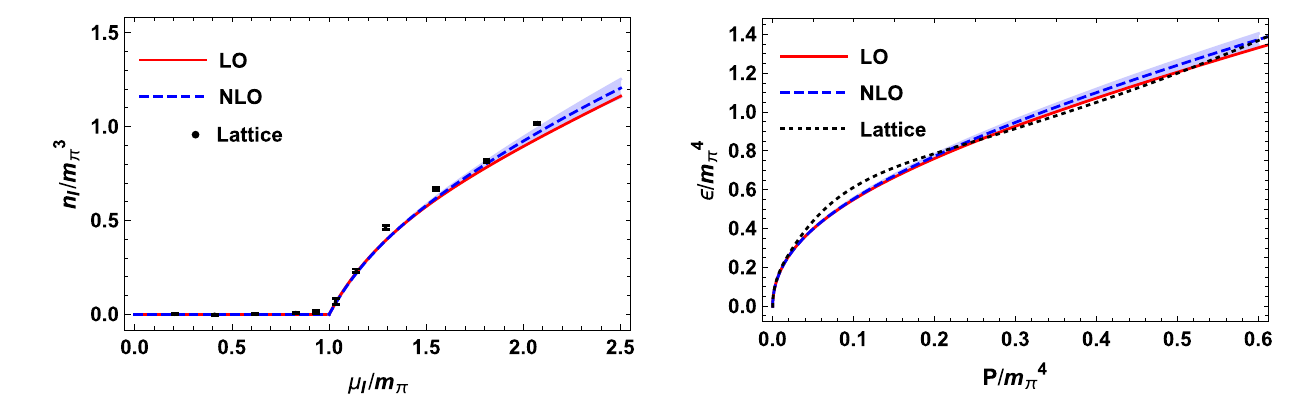
Fig. 5 The normalized equation of state at tree level is the red curve and at one loop is the blue curve using the central values m cen and f cen . The blue band is obtained by varying the parameters m and f in their respective ranges. The dashed line is the lattice results from Ref.